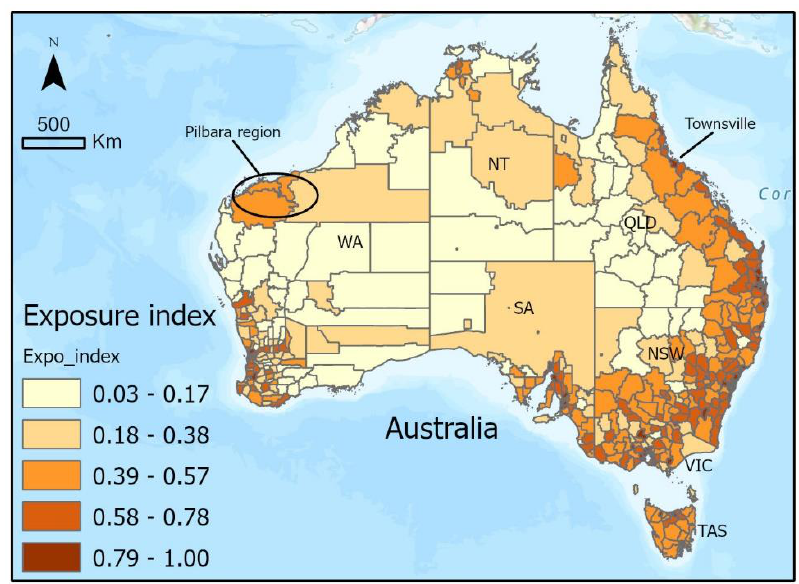
Figure 7. Exposure index map created by equally weighting four exposure indicators.